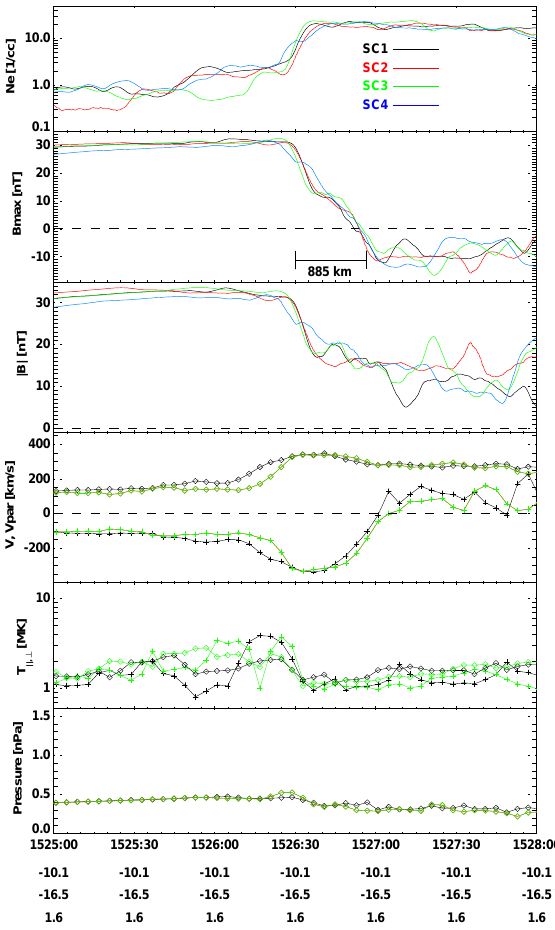
Fig. 8. Plasma and magnetic field data for the crossing near 11:49 UT on 5 July 2001. Plot format and labelling as in Fig. 4. Note the density plateau within the magnetopause, and the enhanced plasma flow speed observed by both C1 and C3.